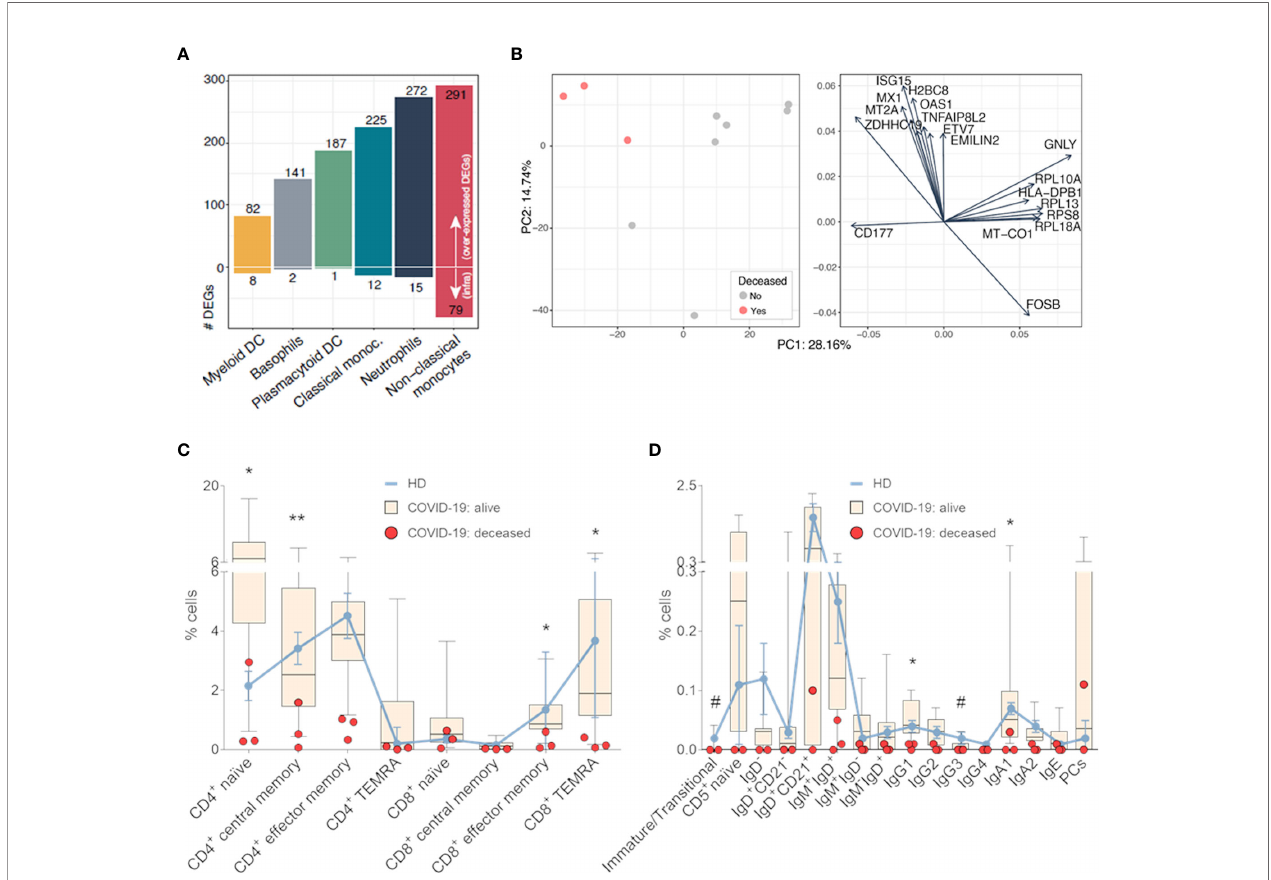
FIGURE 2 | Activation and differentiation of innate and adaptive immune cells after SARS-CoV-2 infection. (A) Number of differentially expressed genes (DEGs) in myeloid dendritic cells (DC), basophils, plasmacytoid DC, classical monocytes, neutrophils and non-classical monocytes, isolated from peripheral blood (PB) samples of COVID-19 patients (n=11) and age-matched healthy donors (HDs, n=4). The number of under- and over-expressed DEGs is depicted, and cell types were ordered from the lowest to the highest number of DEGs. (B) Principal component analysis of RNA-seq data from neutrophils showing partial segregation between COVID-19 patients with favorable vs fatal outcome (left panel). DEGs in neutrophils from COVID-19 patients as shown in left panel (right panel). Percentage of antigen-dependent differentiation of (C) T and (D) B cell subsets in the PB of 14 COVID-19 patients (11 alive and 3 deceased) and 4 age-matched HDs. Lines represent median values in HDs; boxes correspond to minimum-to-maximum values in alive patients; and dots indicate individual deceased patients. * P <0.05; ** P <0.01 between alive and deceased COVID-19 patients. Hash symbol (#) indicates signi fi cant differences between HDs and COVID-19 patients ( P <0.05). Statistical signi fi cance was calculated using the Mann-Whitney test. CM, central memory; EM, effector memory; TEMRA, effector memory re-expressing CD45RA T